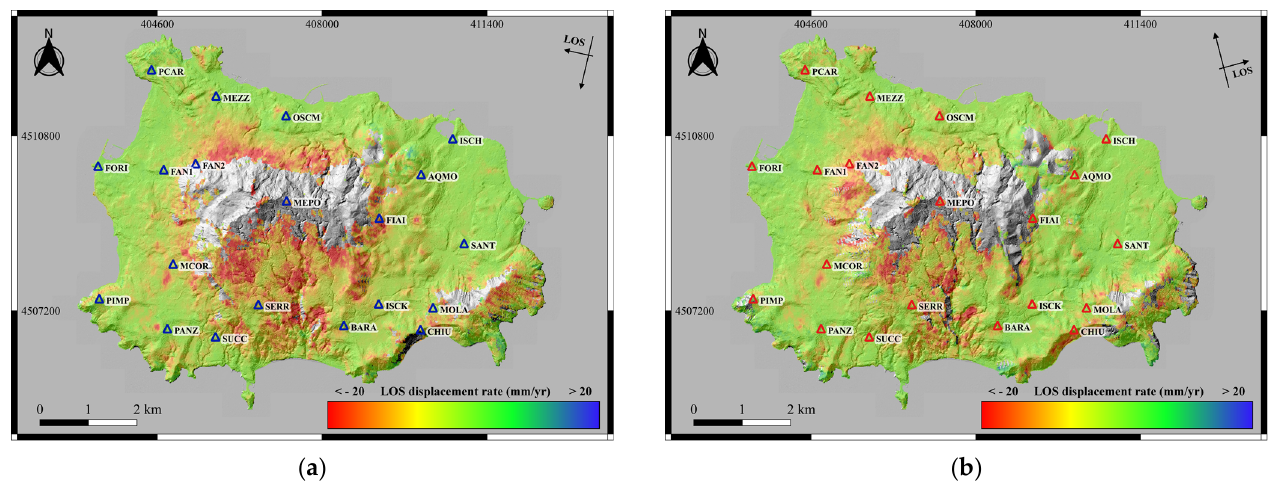
Figure 6. Descending ( a ) and ascending ( b ) LOS displacement maps computed by using Sentinel-1A data.